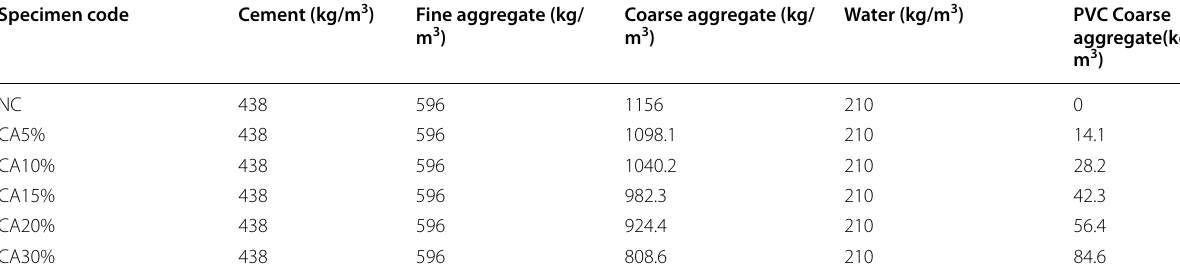
Table 1 Concrete mixing ratio.